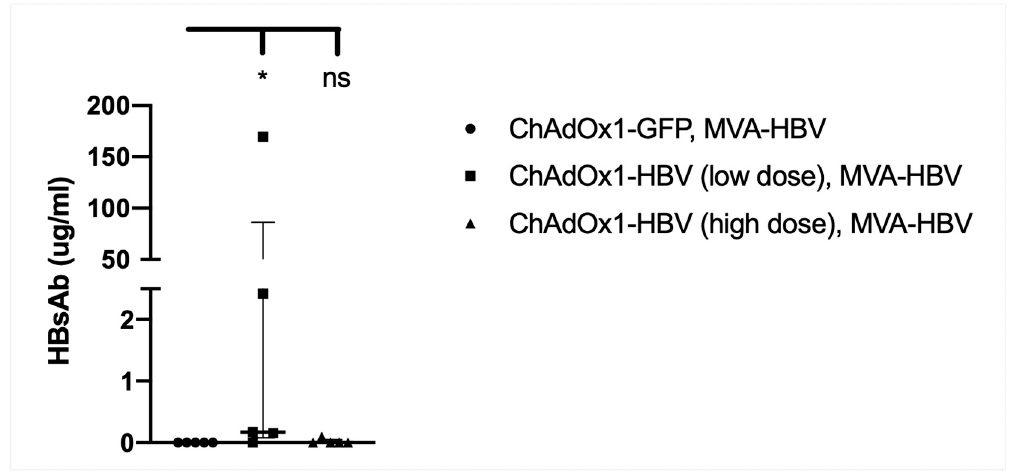
Figure 8. Vaccination with MVA-SIi-CP mut TPA-S (sh) 7–8 weeks after ChAdOx1-SP-SIi-CP mut TPA-S (sh) induces HBs-antibody. C57BL6 mice, n = 5 per group, were given intramuscularly injections with 5 × 10 5 IU per mice (low dose) or 5 × 10 7 IU per mice (high dose) of ChAdOx1-SP-SIi-CP mut -TPA-S (sh) at week 0 followed by 2 × 10 6 pfu per mice of MVA-SIi-HBV-CP mut TPA-S sh at week 7–8. The third group of C57BL6 mice ( n = 5), received 5 × 10 7 IU per mice of ChAdOx1-GFP at week 0 followed by 2 × 10 6 pfu per mice of MVA-HBV at week 8. Sera were collected 14 days post MVA vaccination and the levels of anti-HBs induction in response to vaccination was quantified by ELISA. Anti-HBs quantitation based on commercial standard mouse monoclonal antibodies to surface (GeneTex, GTX40707) above background value of naïve un-vaccinated sera are shown. Median and interquartile ranges are shown. The Kruskal–Wallis test and Dunn’s multiple comparisons test were used for statistical comparison of medians between groups. * p < 0.05, ns = not significant.